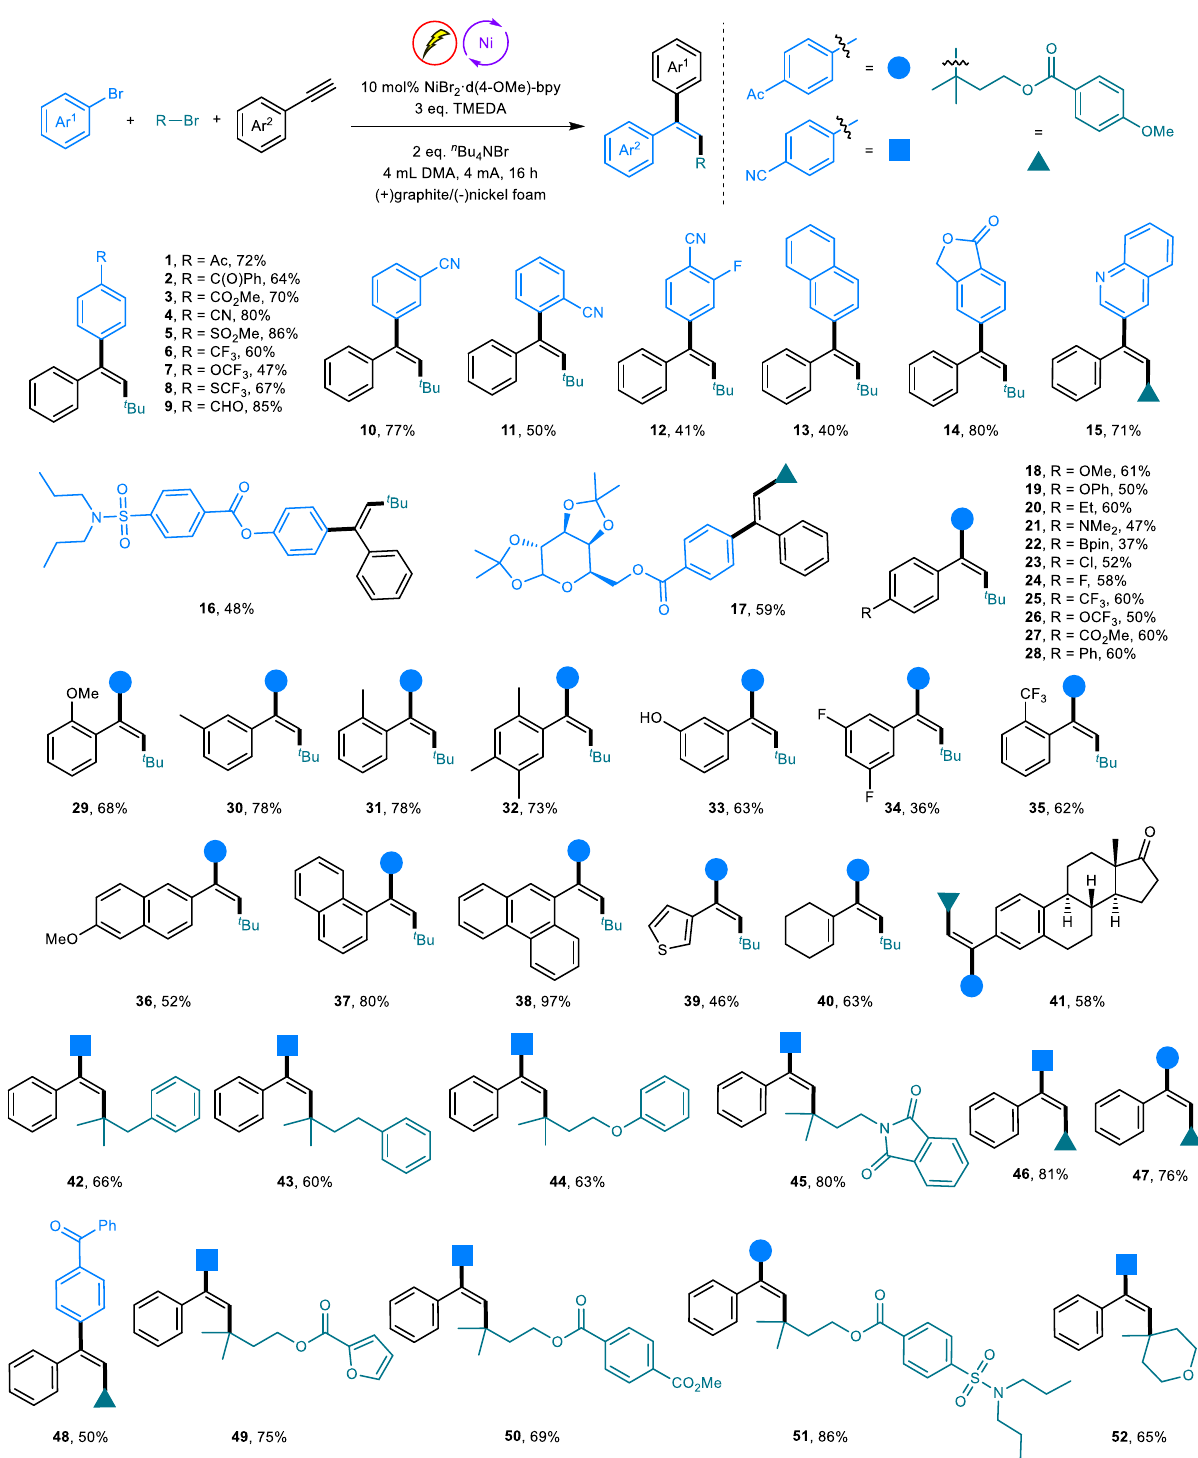
Fig. 2 Scope of the nickel catalyzed electrochemical arylalkylation of alkynes. Reactions were performed with 0.2 mmol of aryl bromides, 0.4 mmol of alkynes, and 0.6 mmol of alkyl bromide. Yields are of the isolated